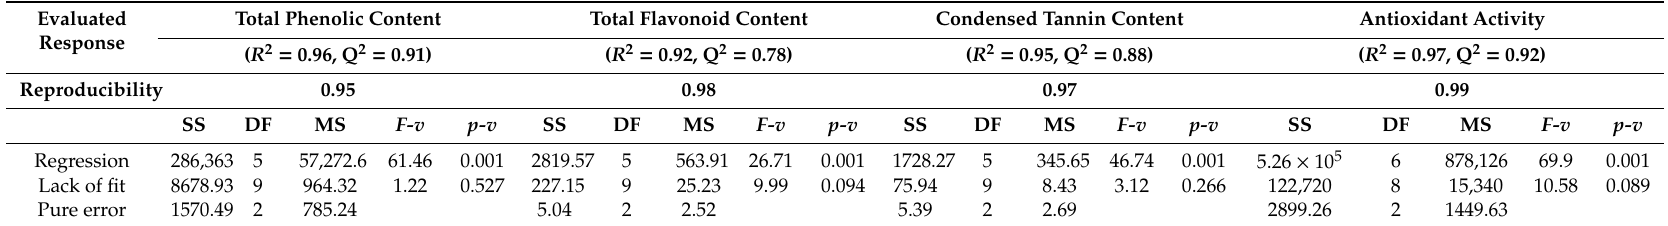
Table 4. Statistical parameters after data analysis and fit with factorial